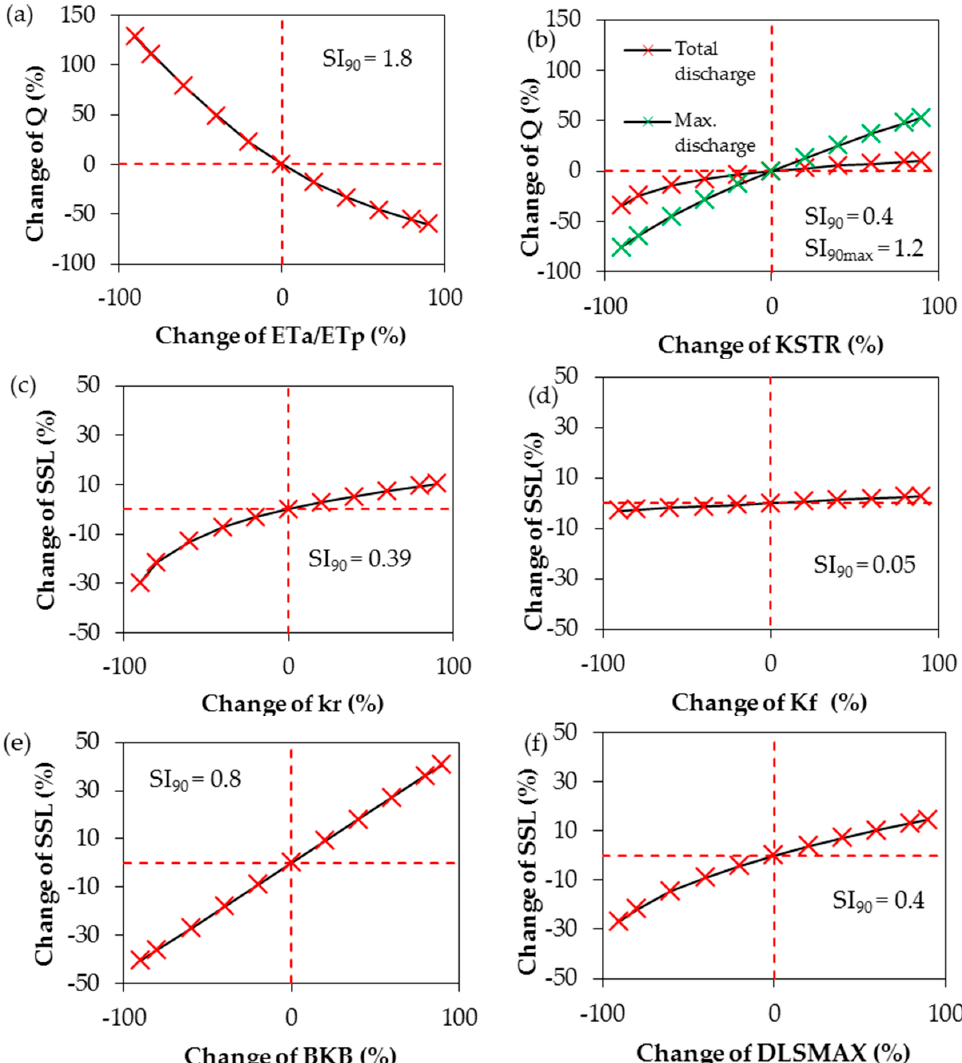
Figure 3. Scatter plots showing the sensitivity of water discharge Q to the ratio of actual to potential evapotranspiration (ETa/ETp) ( a ); and surface roughness (KSTR) ( b ); and the sensitivity of the catchment suspended sediment load (SSL) to the raindrop erodibility coefficient (k r ) ( c ); the overland flow erodibility (k f ) ( d ); the bank erodibility (BKB) ( e ); and the depth of loose sediment (DLSMAX) ( f ). Red dashed lines indicate the base run used for comparison. SI 90max indicates the SI 90 for the maximum discharge.